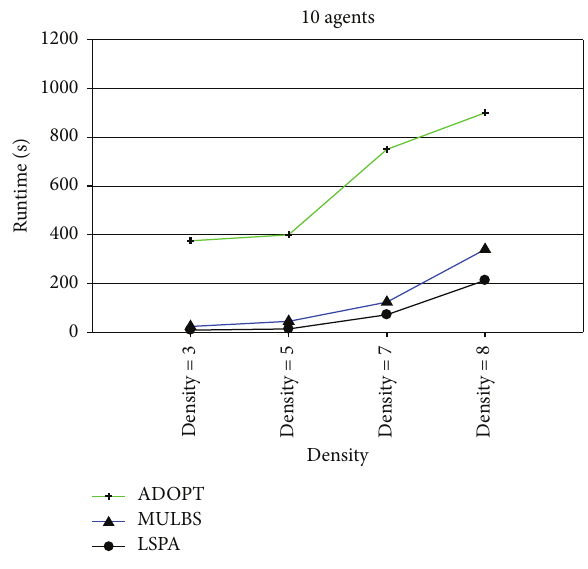
Figure 9: Runtime with 10 agents and densities 3, 5, 7, and 8.